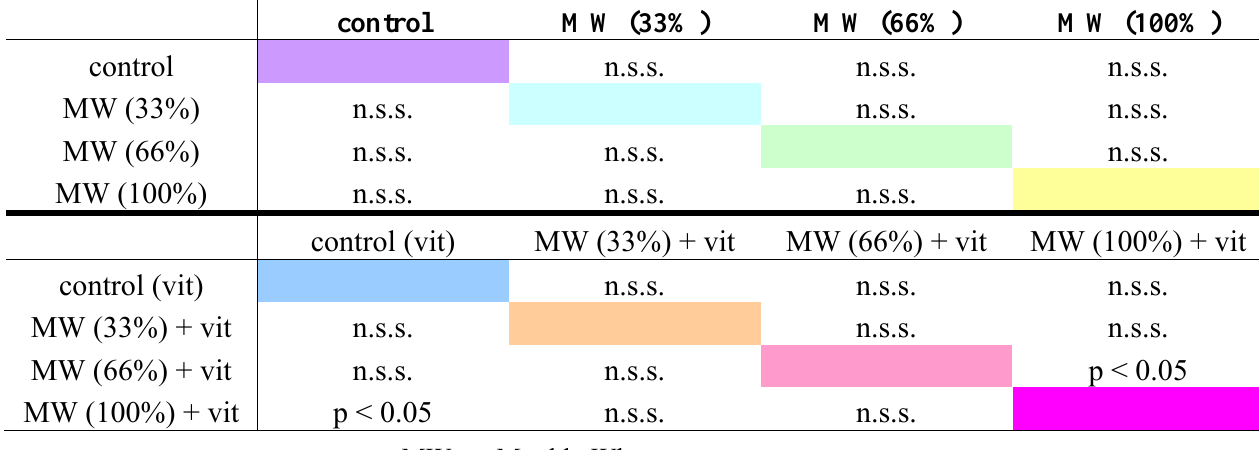
Table 2. Statistical treatment of rats weight at the end of the experiment by using one way ANOVA, Scheffeho test. Differences with p < 0.05 were considered significant, N.S.S. means any statistical